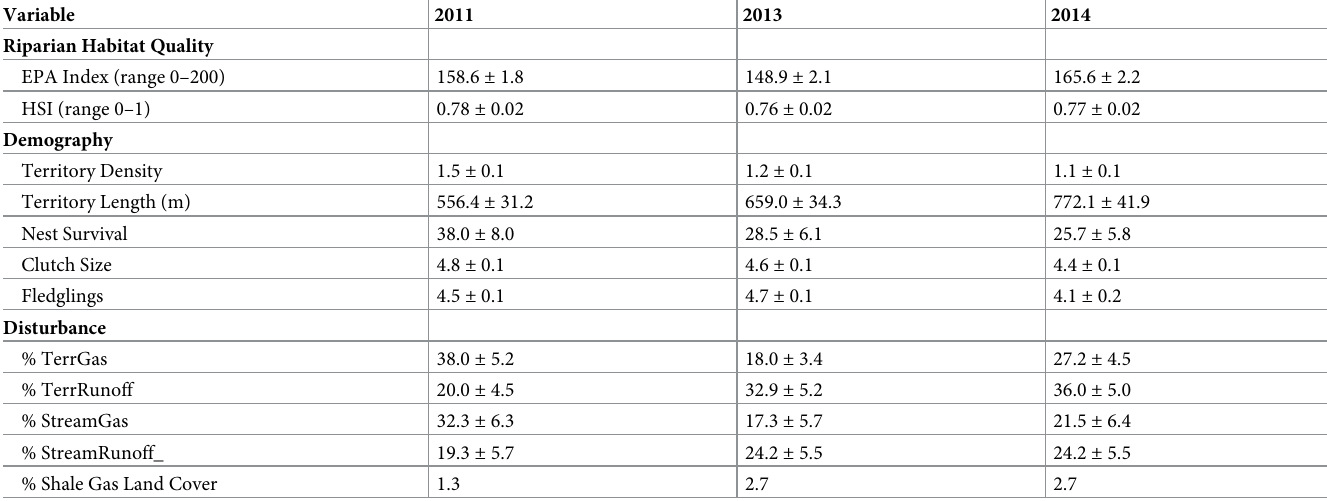
Table 1. Louisiana Waterthrush annual demographic, riparian habitat quality, and shale gas disturbance metrics (mean ± SE) at Lewis Wetzel Wildlife Manage- ment Area, WV at peak (2011) and later stages (2013–2014) of shale gas development. Our study associated waterthrush response to aquatic prey community changes in relation to shale gas disturbance. All metrics are a subset of those originally reported in Frantz et al. [28] excepting % shale gas land cover which is cited from Farwell et al. [33]. Variable names are defined in S2